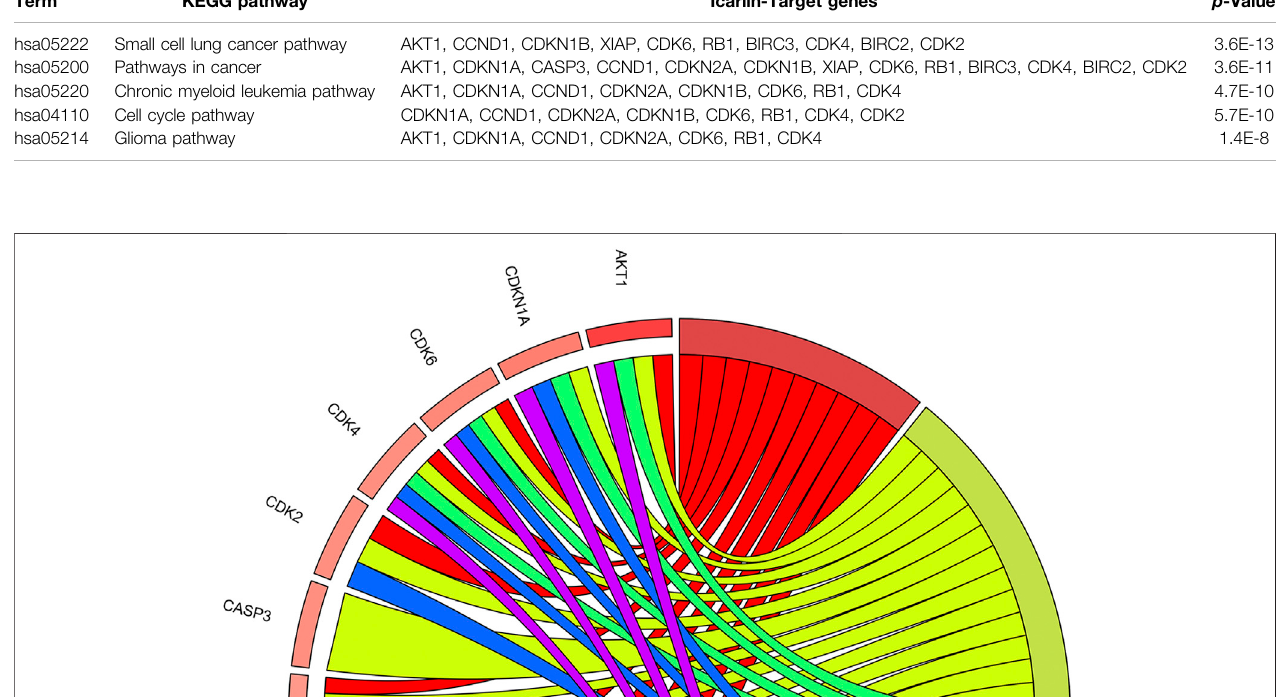
Frontiers in Cell and Developmental Biology |